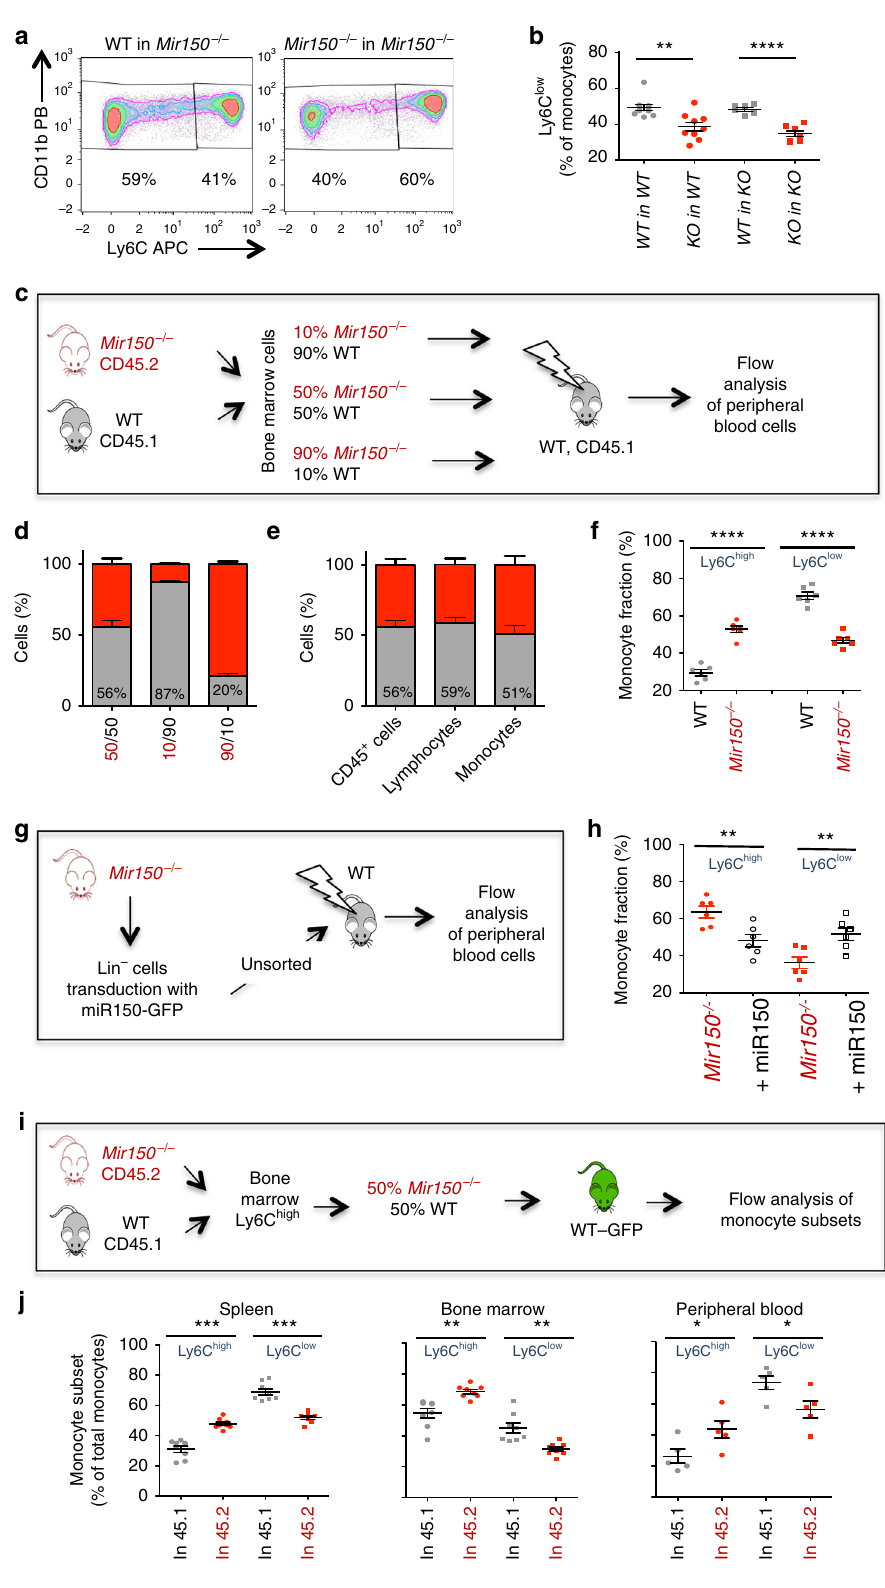
cells (Supplementary Figure 7A). ChIP-seq experiments con- fi rmed that H3K4me3 mark was located on R3 in healthy donor monocytes as well as in those collected from CMML patients (Fig. 5d; peak calling with a P value of 0.05: 107,503, 119,009,